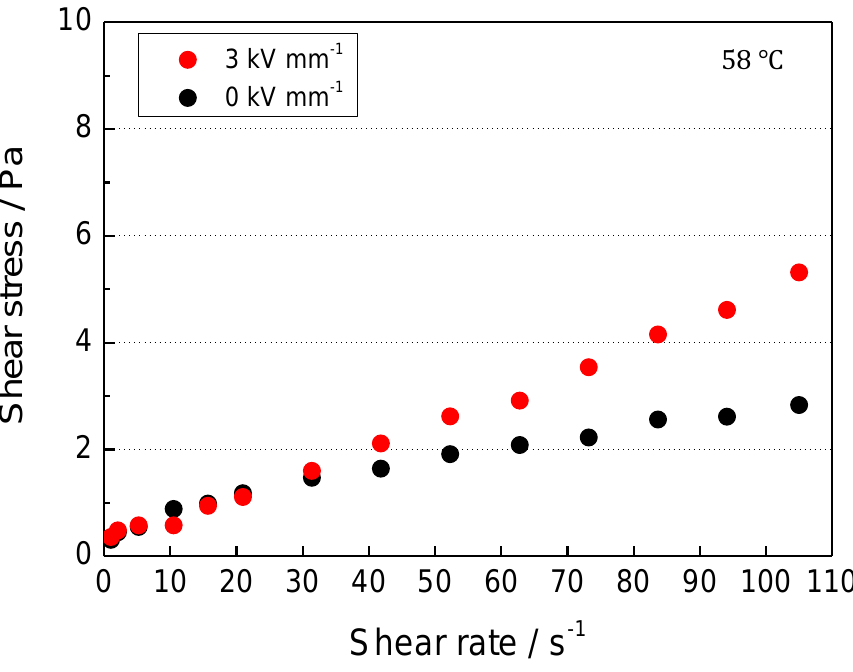
Figure 8. Shear stress as a function of shear rate of the composite (GNP-C6-LC (10 wt%) in 7CT) under 0 and 3 kV mm − 1